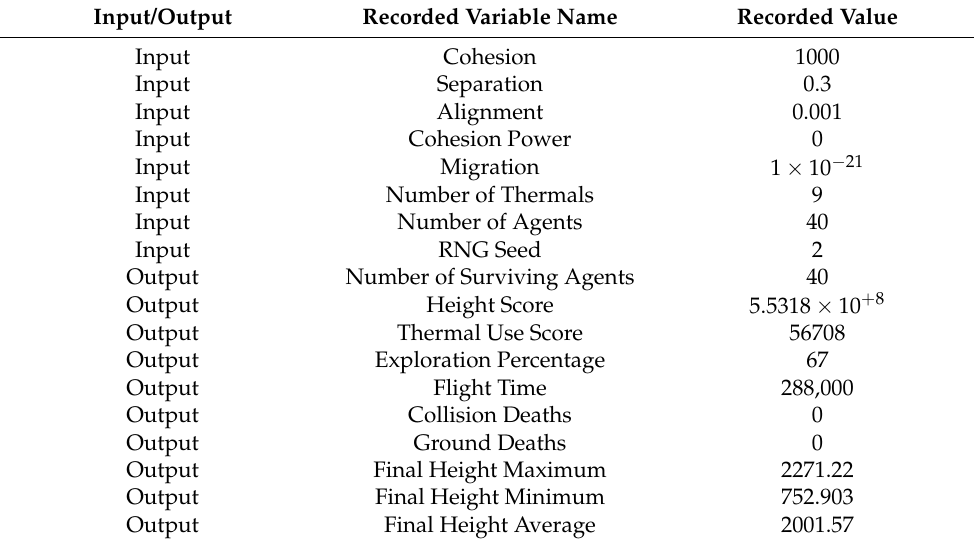
Table 2. An example of the recorded data for each individual simulation, including the varied input parameters and the resultant output